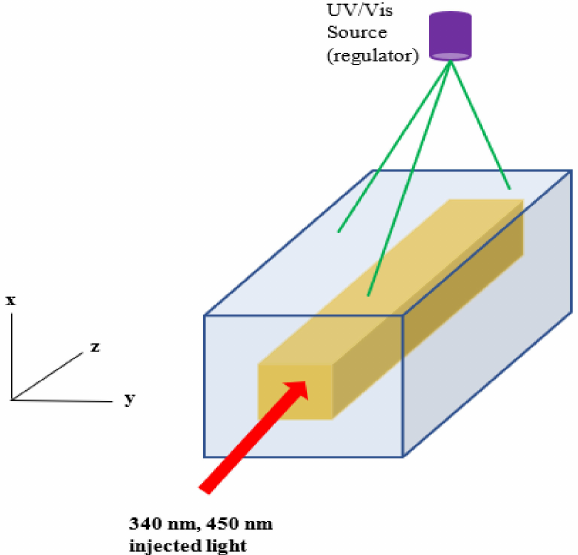
Figure 2. Buried waveguide structure. Gold-colored region represents PDMS–AAP composite. UV-Vis regulating source is assumed external and in proximity to